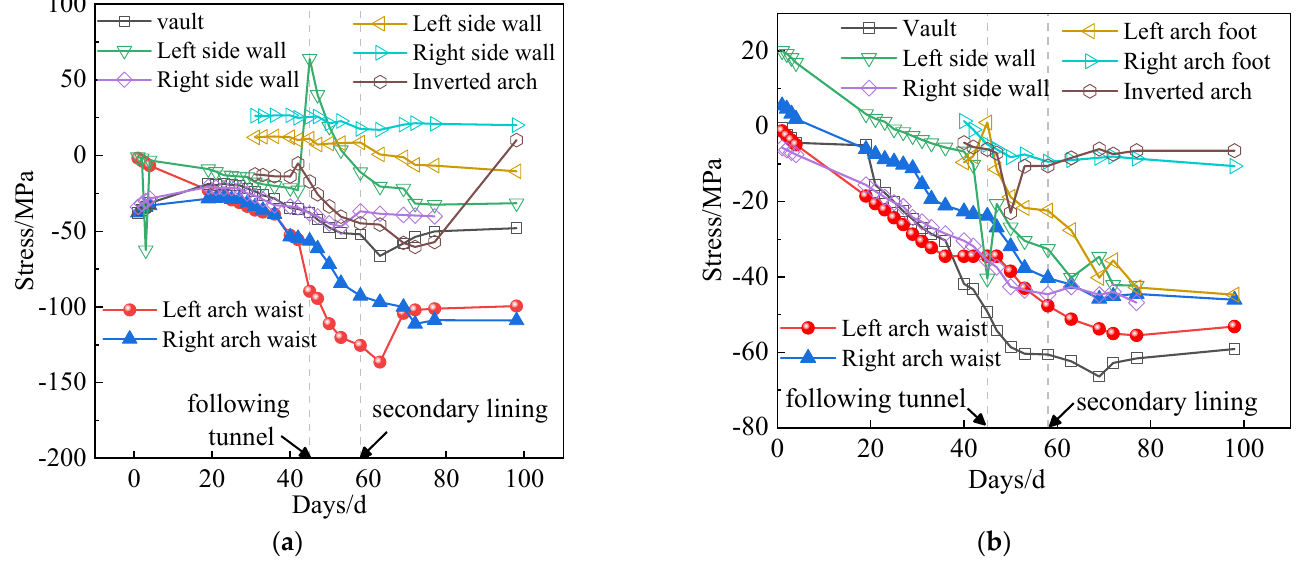
Figure 7. Stress-time curve of the steel arch at section ZK0+730: ( a ) Outer flange; ( b ) Inner flange. The stress variation of the measurement points in the soil layer is the main one. It can also be seen from Figure 7 that the locations with larger stress stability values of the steel arch in this test section are the vault and the left and right arch waist, and the size order is the right arch waist located in the soil layer and far from the side of the middle rock column, the left arch waist located in the middle rock column side of the rock